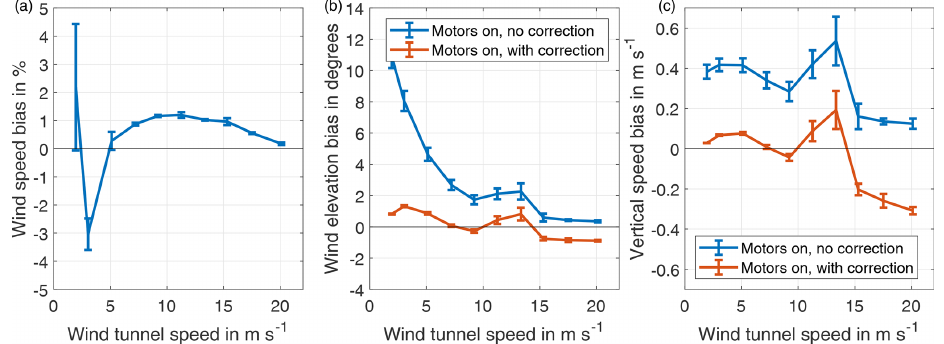
Figure 10. Bias of wind speed (a) , elevation (b) and vertical speed (c) measurements with running motors, tested in a large wind tunnel. Wind speed measurements with stopped motors are used as a reference. Wind speed bias is ≤ 1% for wind speeds above 5ms − 1 . A simple correction algorithm limits the elevation bias to ≤ 1 ◦ , and the vertical speed bias to ≤ 0.3ms − 1 , even at very high wind tunnel speed.